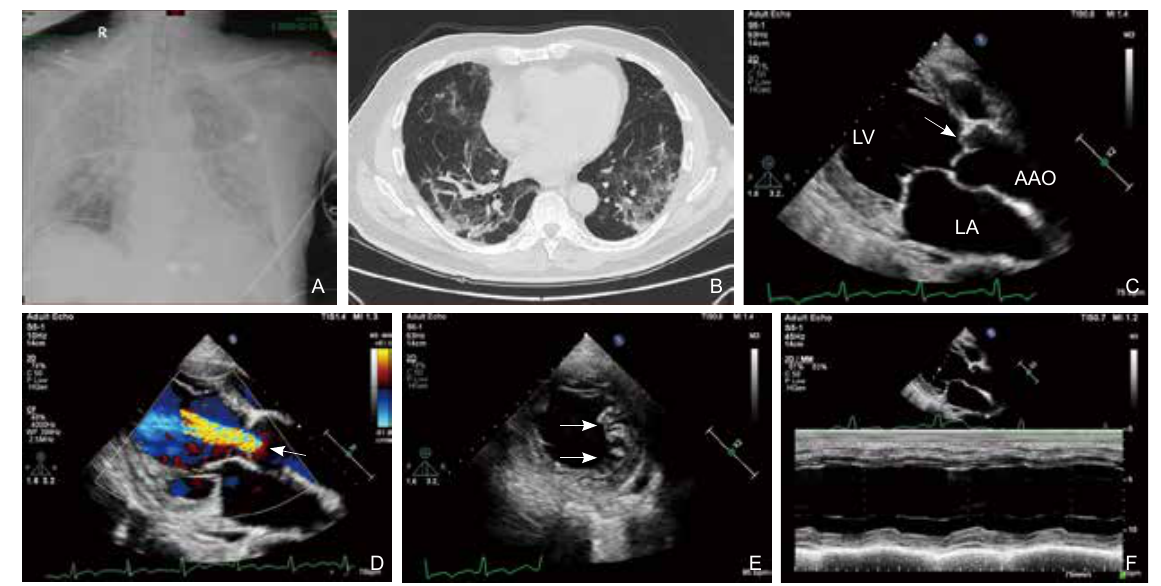
Figure 1 Valvular disease. A 73-year-old female patient was admitted to the hospital for 12 days due to fever, with palpitation, chest tightness and shortness of breath. COVID-19 nucleic acid was positive, oxygen saturation was 85%, and emergency bedside ultrasound was performed. (A) X-ray of the lung shows multiple fuzzy patchy shadows in both lungs. (B) CT of the lung shows ground glass changes in both lungs. (C) Bedside ultrasound shows calcification of the aorta (shown by the white arrow), and enlargement of the left heart. (D) Severe insufficiency of closure can be seen in the diastolic period of the aortic valve (shown by the white arrow). (E) Increased muscle trabeculae in the middle and apical segments of the left ventricular sidewall, and abundant muscle sinus spaces (shown by the white arrow). As shown in the head, the dense myocardium is obviously thinner, while the non dense myocardium is 2.3:1. (F) M-mode ultrasound shows the diffuse decrease of left ventricular wall motion, the thickening rate of the left ventricular wall is less than 5mm, and the EF value measured by Simpson is 40%. La, left atrium; LV, left ventricle: AAO, ascending aorta